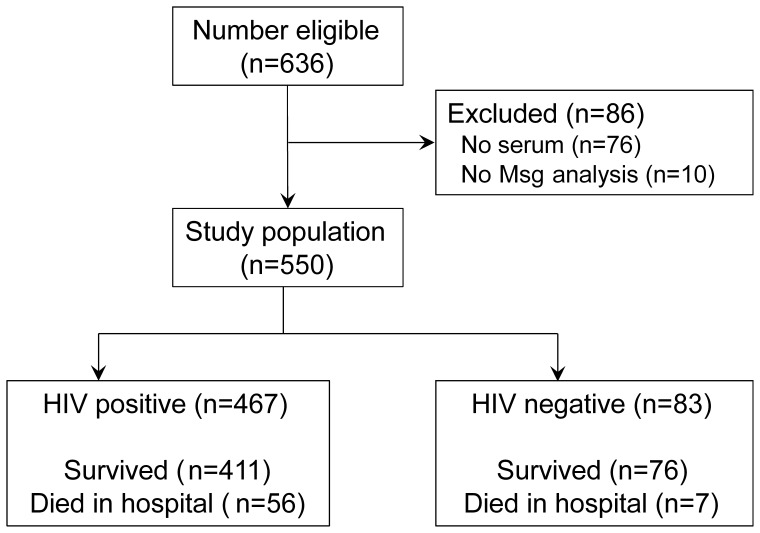
Study enrollment flow diagram.